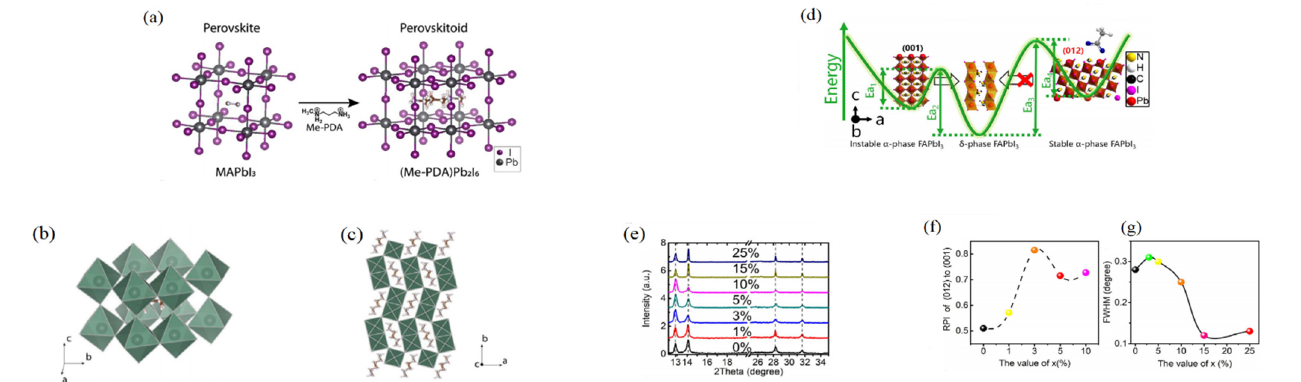
Figure 7. ( a ) The structures of (Me-PDA)Pb 2 I 6 and MAPbI 3 ; Side view ( b ) and top view ( c ) of crystal structure of (Me-PDA)Pb 2 I 6 . (Reprinted with permission from Ref. [92]. Copyright 2021 Elsevier Inc.). The stability of the α -FAPbI 3 was affected by adding Ac − . ( d ) Schematic illustration; ( e ) The calibrated XRD spectra of the perovskite materials with different amount of AC − ; ( f ) The evolution of RPI of XRD diffraction peak (102) to peak (001); ( g ) FWHM of (001) with different amount of AC − . Reprinted with permission from Ref. [96]. Copyright 2021 Wiley-VCH GmbH.